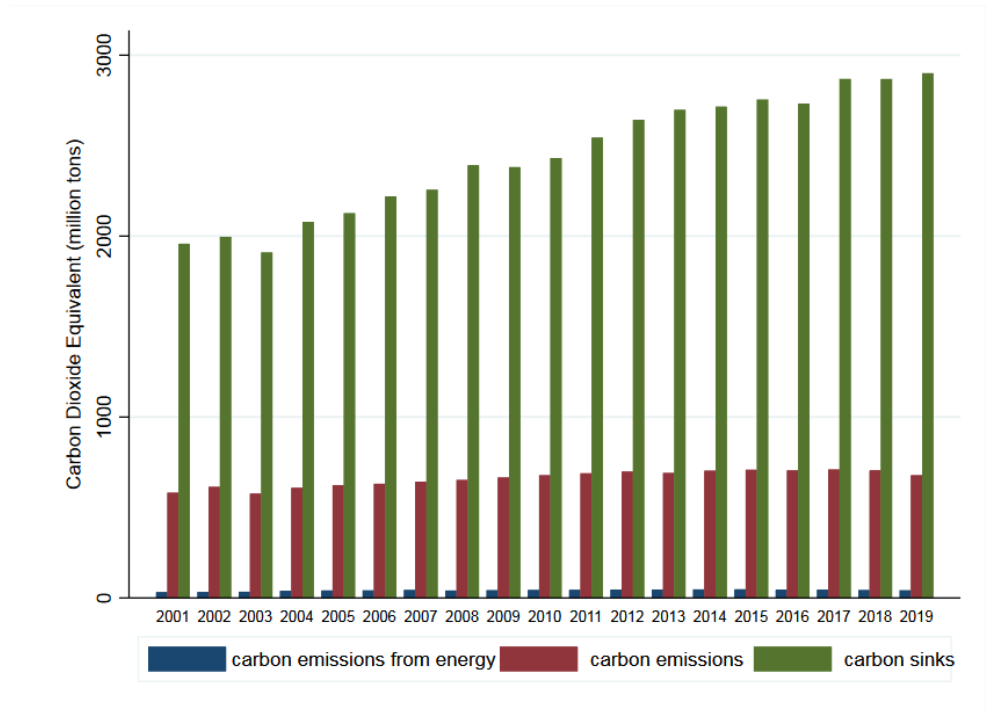
Figure 1. Planting carbon emissions and carbon sinks changes from 2001 to 2019.